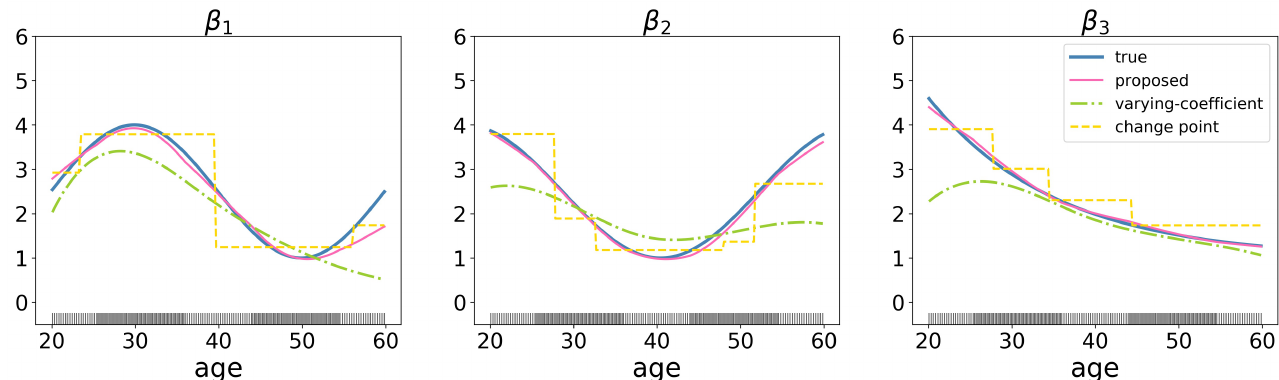
Figure 1. Estimation results for a toy example with N = 200 subjects and p = 10 genes with three important genes. The values of the gene expressions are generated from multivariate normal distribution N ( 0, Σ ) , where Σ ii = 1 and Σ ij = 0.3 | i − j | . The ticks on the x -axis represent the values of the auxiliary variable